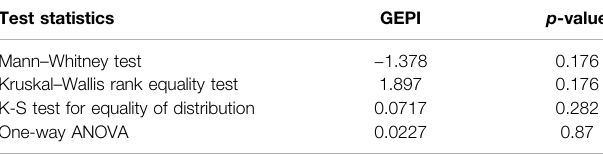
TABLE 10 | Differences in energy ef fi ciency. TABLE 11 | Econometric estimate of green